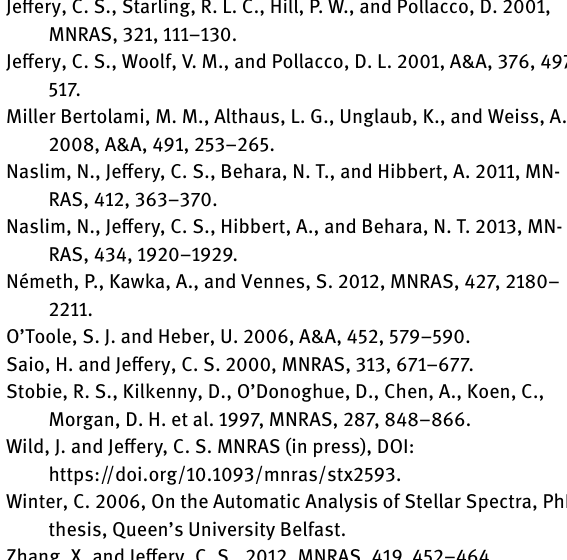
Figure 6. Surface properties of J18455−4138 and J19376−4303, compared with extreme helium stars and related objects. The positions of the Eddington limit (Thomson scattering: dashed), luminosity-to-mass contours (solar units: dotted) and lower bound- aries for pulsation instability (metallicities Z =0.004, 0.01, 0.03: dot-dashed) (Jeffery and Saio 1999) are also shown. Post-merger evolution tracks for models of He+He white dwarf mergers (Zhang and Jeffery 2012, 0.30+0.25 and 0.30+0.30 M ⊙ ) are shown in ma- roon. Part of the post-flash track of a 0.46921 M ⊙ ’late hot flasher’ (metallicity Z = 0.01) is shown in orange (Miller Bertolami et al.